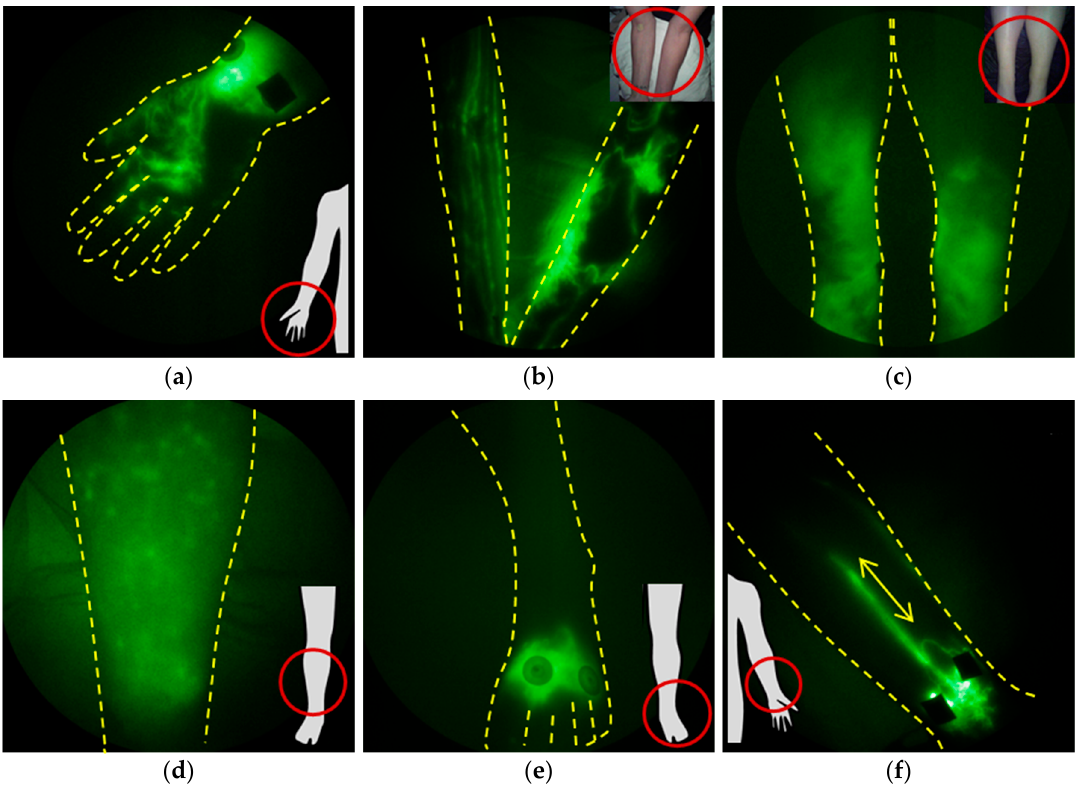
Figure 6. Typical NIRF-LI images of lymphatic dysfunction. The retrograde movement of contrast agent into the dermal lymphatics, known as dermal backflow, is the most common sign of dysfunction and is shown here ( a ) around the injections in the wrist and into the hand and fingers. ( b ) Dermal backflow and tortuous lymphatic vessels present in the affected arm of a subject but not the contralateral asymptomatic arm. ( c ) Extensive dermal backflow in both lower legs of a subject. ( d ) Extravascular dye is sometimes observed in the interstitial space in some subjects. ( e ) Radial movement of dye around the injection sites is also observed in some subjects and is often one of the first anatomical signs of dysfunction. ( f ) Lymphatic reflux is observed, indicating that lymphatic valve dysfunction may occur, in some subjects (adapted from [13], Rasmussen JC, et al., 2010). Injection sites are covered with round bandages and/or black vinyl tape. The brightness and contrast of the images have been adjusted to facilitate the visualization of the 16-bit imaging depth.